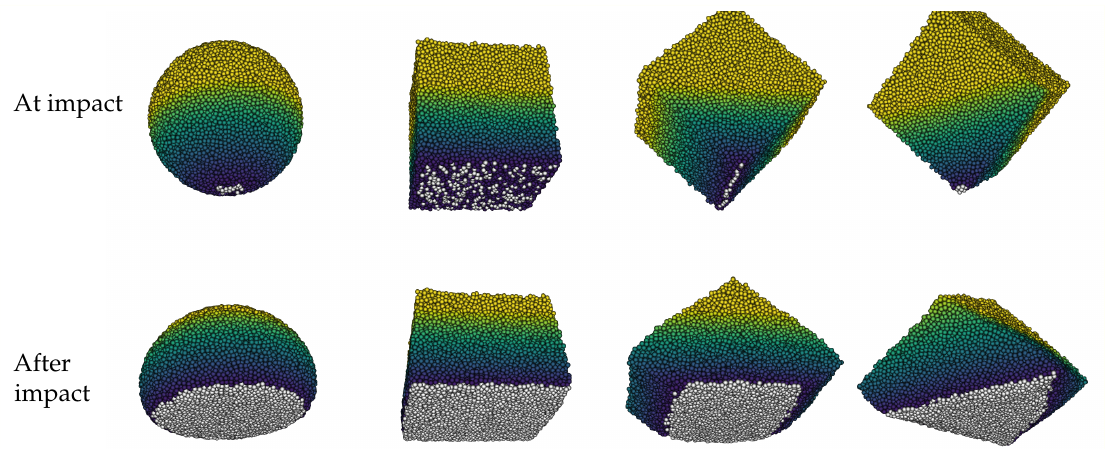
Figure 7. Illustration of the particle deformation after impact. Particles are colored to reflect their z-coordinate (height above the surface of the wall) and those considered as having wall contact are marked in